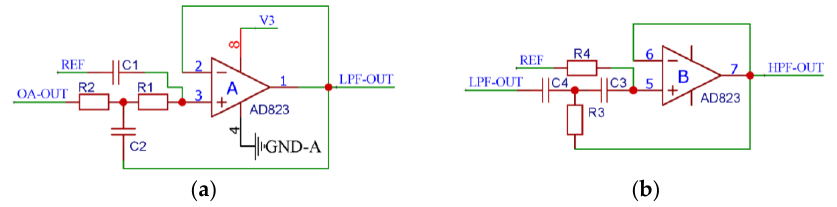
Figure 10. Schematic diagrams of the Butterworth filter circuits: ( a ) high-pass filter; ( b ) low-pass